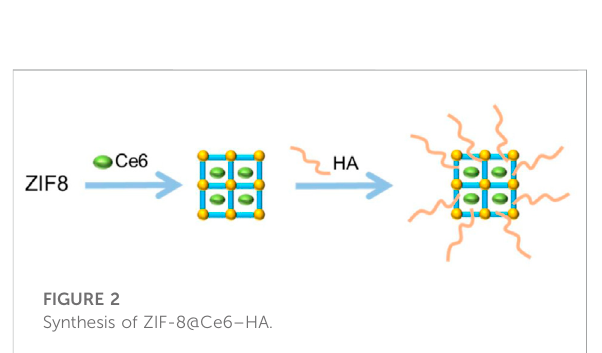
FIGURE 2 Synthesis of ZIF-8@Ce6 –